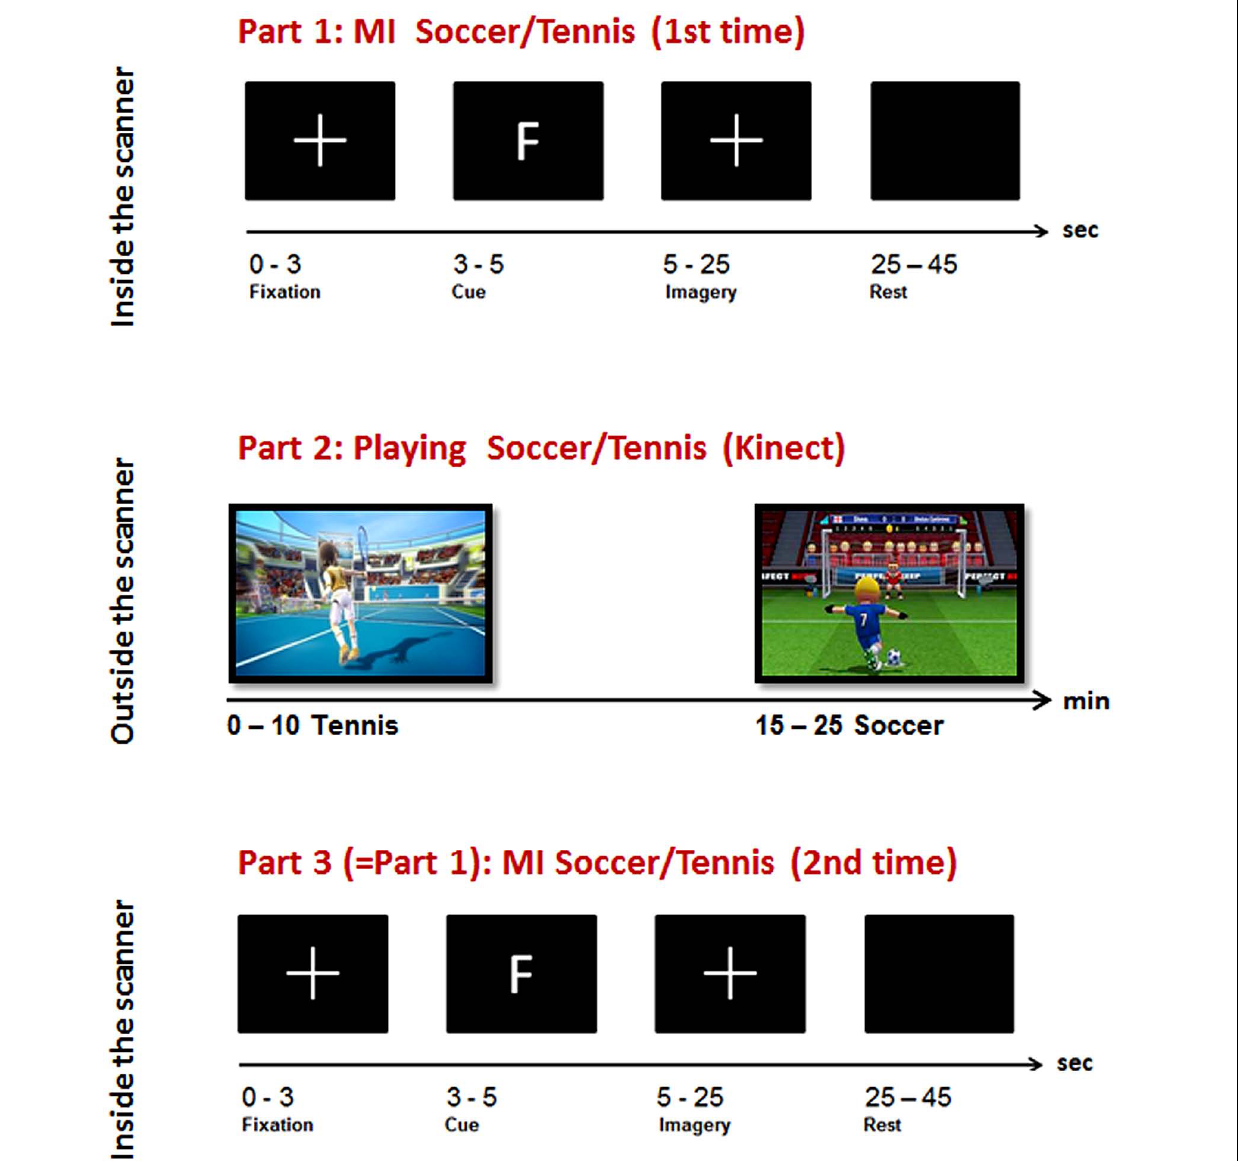
FIGURE 1 | Overview of the experimental paradigm: top: Part 1, Imagery task inside the scanner; middle: Part 2, sports exercise outside the scanner; bottom: Part 3, Imagery task inside the scanner.